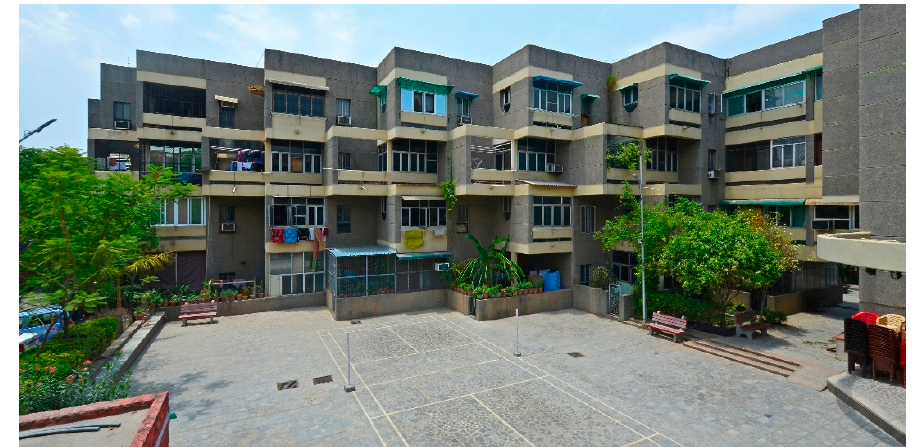
Figure 1. Yamuna Apartments, New Delhi (1980) by the Design Group (Photo: Author).